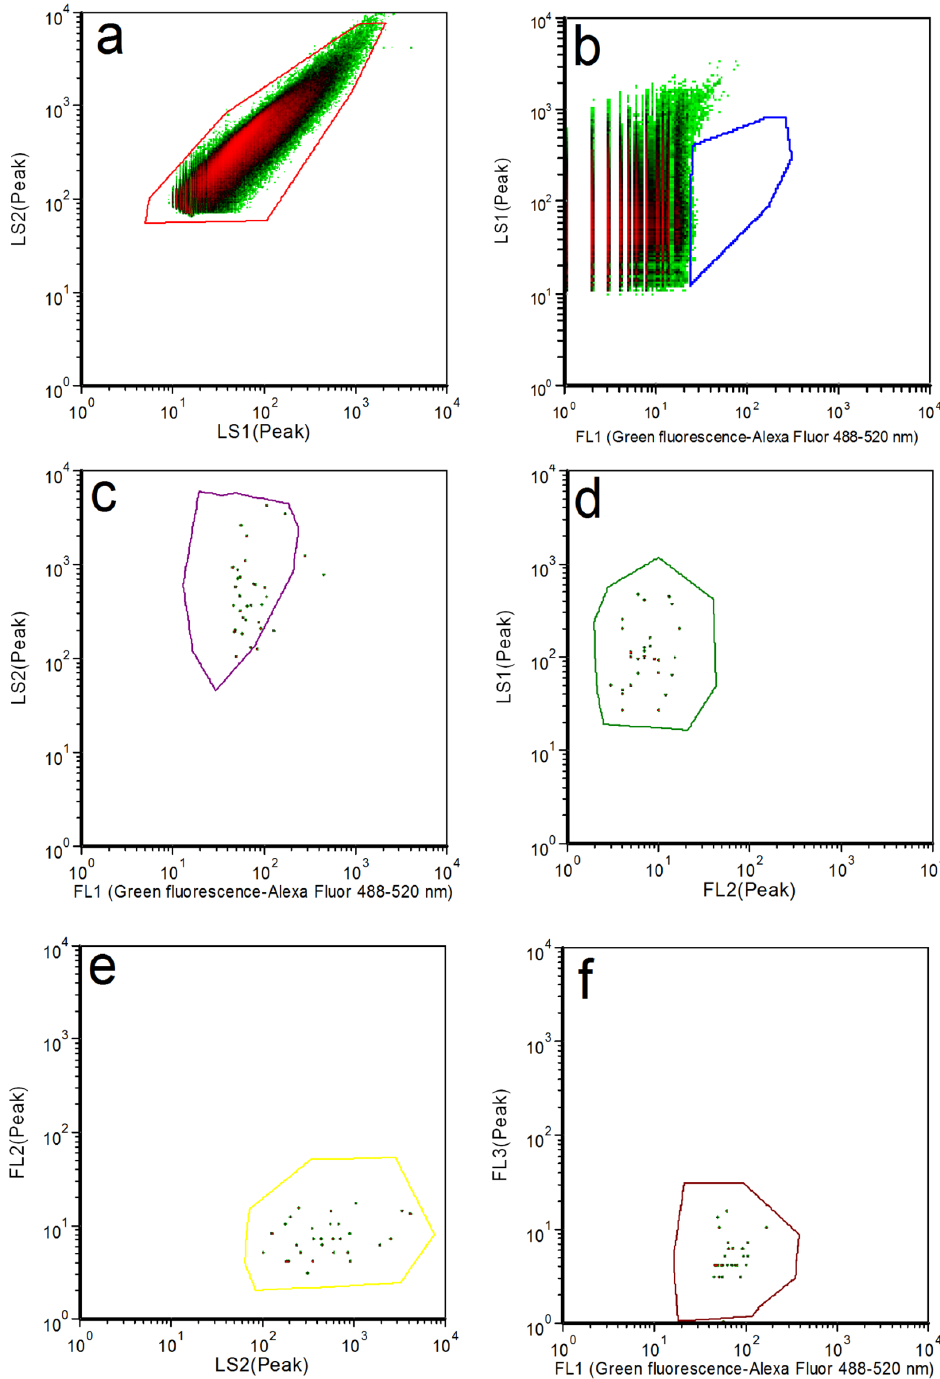
Fig 3. Flow cytometer analysis of Salmonella enterica serovar paratyphi A (ATCC 11511) through serial gates. The same gate logic is used as in Fig 2.